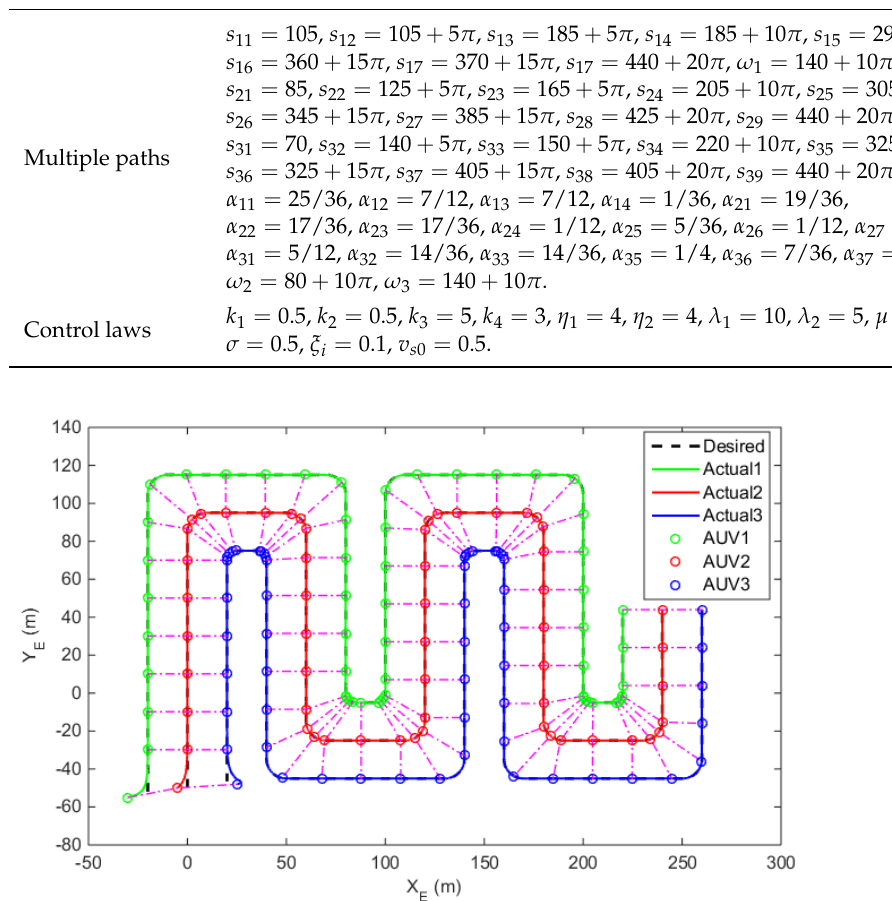
Figure 6. Snapshots of three AUVs in different time periods.